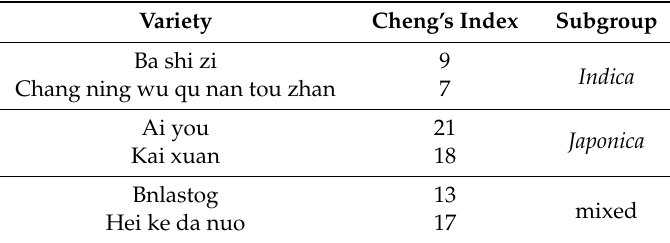
Figure 4. Expression patterns of differentially expressed genes among six varieties. ( A ) Comparison based on the genes relating to Al-tolerance; ( B ) Comparison based on the genes relating to Al-sensitivity. SG1, SG2, and AD represent Indica , Japonica , and the mixed subgroup, respectively. Table 2. Cheng’s index of six varieties in this study.